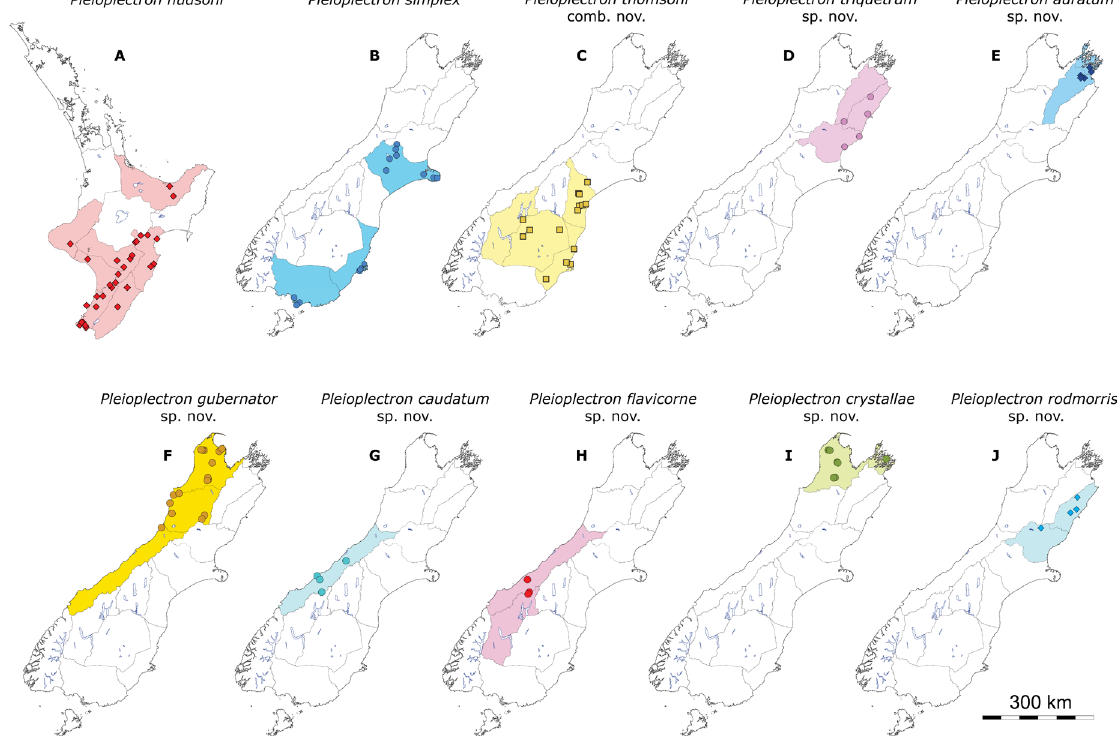
Fig. 18. Known distribution of cave wētā in the genus Pleioplectron Hutton, 1896. A . North Island, New Zealand, showing the distribution of P. hudsoni . B–J . South Island, New Zealand, showing the distribution of the remaining nine